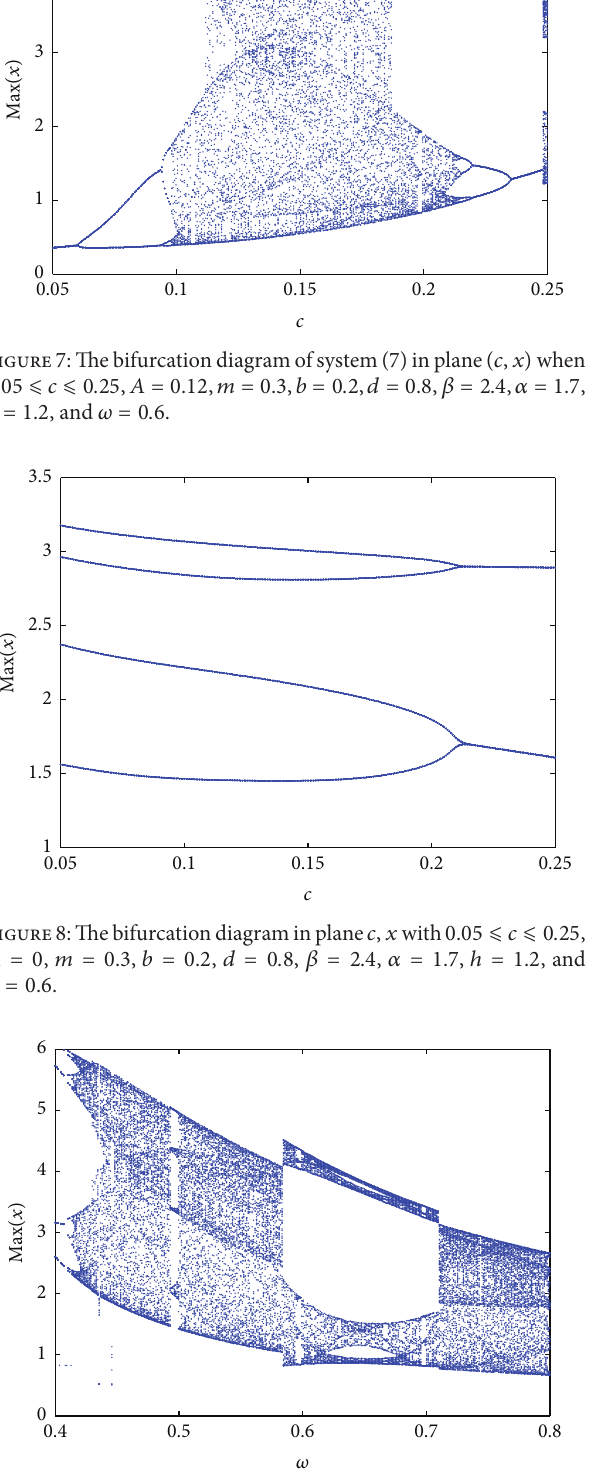
Figure9:Thebifurcationdiagramofsystem(7)inplane (𝜔, 𝑥) when 0.4 ⩽ 𝜔 ⩽ 0.8 , 𝐴 = 0.12 , 𝑚 = 0.3 , 𝑐 = 0.2 , 𝑏 = 0.2 , 𝑑 = 0.8 , 𝛽 = 2.4 , 𝛼 = 1.7 , ℎ = 1.2 , and 𝜔 = 0.6